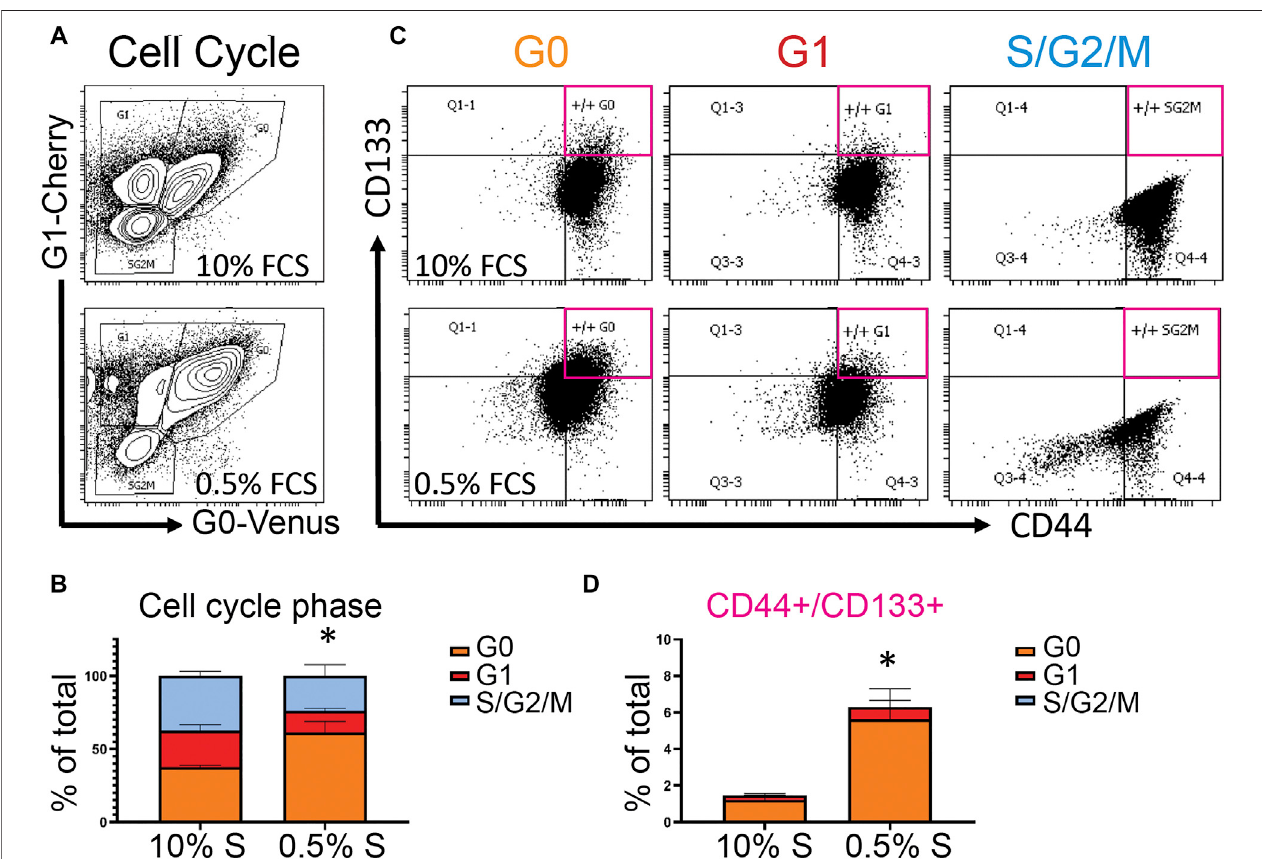
FIGURE 4 | Quiescent prostate cancer cells are enriched for a subpopulation of cells that express potential cancer stem cell markers, (A) Flow cytometry plots of cell cycle phase of PC3 Venus-Cherry cells grown with 10% serum (FCS) or 0.5% serum (FCS) for 3 days (B) Quanti fi cation of the cell cycle phase data (C) Flow cytometry for CD133 and CD44 to assess cancer stem cell marker expression in each of the cell cycle populations. (D) CD133/44 double positive cells from each cell cycle phase group, quanti fi ed as a percentage of the total events in panel A. Quanti fi ed data in panels C and D represent mean ± SEM of three independent experiments. * represents p < 0.05 for the G0 population by Student ’ s t -test. Flow cytometry plots in panels A and B show a representative experiment.